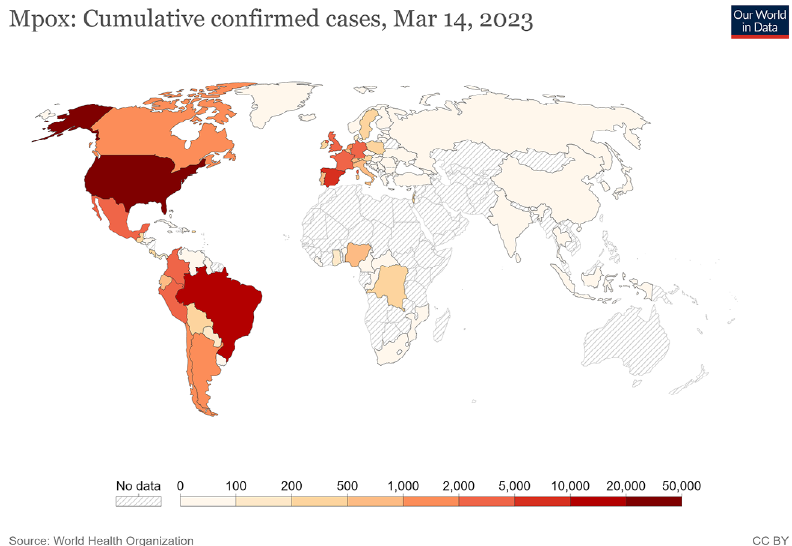
Figure 1. Geographical distribution of confirmed cases of mpox globally.